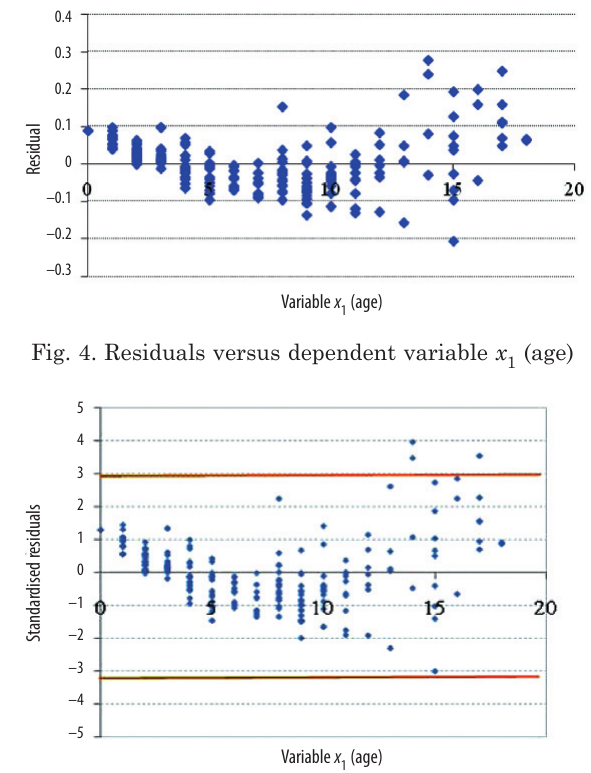
Fig. 5. Standardised residuals versus dependent